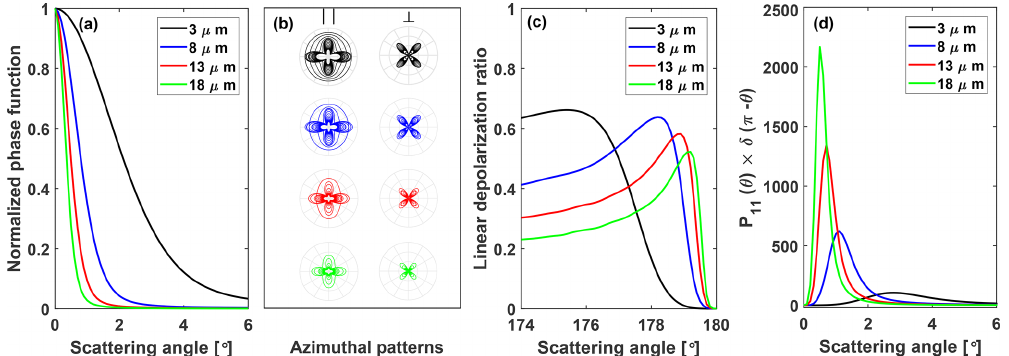
Figure 2. (a) Normalized scattering matrix element P 11 (normalized to the maximum at 0 ◦ scattering angle) as a function of forward scattering angle θ f for four droplet effective radii (given as numbers), (b) azimuthal patterns (computed with the MS model for the entire range of azimuthal angles from 0 to 2 π ; see Fig. 1) of the co-polarized (cid:107) and the cross-polarized ⊥ signal components at scattering angles θ b between 170 and 189 . 5 ◦ for the different droplet diameters, (c) droplet linear depolarization ratio δ = S ⊥ /S (cid:107) with the lidar signal components S ⊥ and S (cid:107) (obtained from azimuthal integration over the range from φ = 0–2 π in b ) as a function of the backscattering angle θ b from 174 ◦ to 180 ◦ for the four droplet sizes, and (d) scattering matrix element P 11 (θ) at θ f (in a ) multiplied by the depolarization ratio at θ b = π − θ f (in c